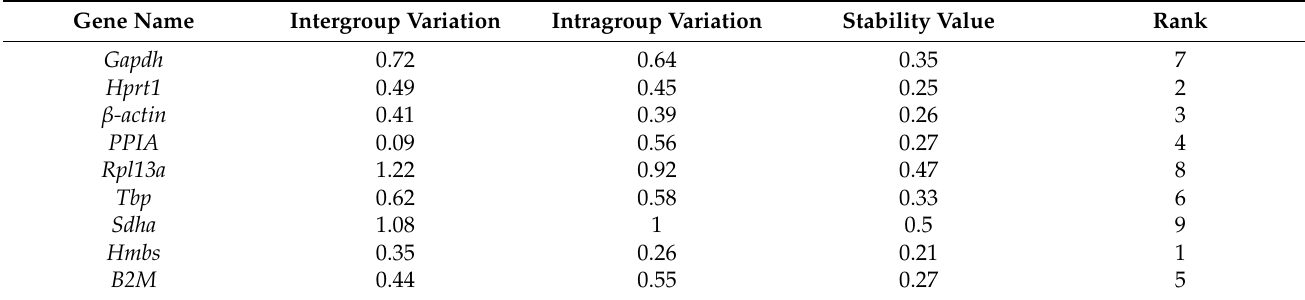
Table 12. Expression features in hypothalamus tissues at the developmental stage of PND 24w under different photoperiod conditions analyzed by